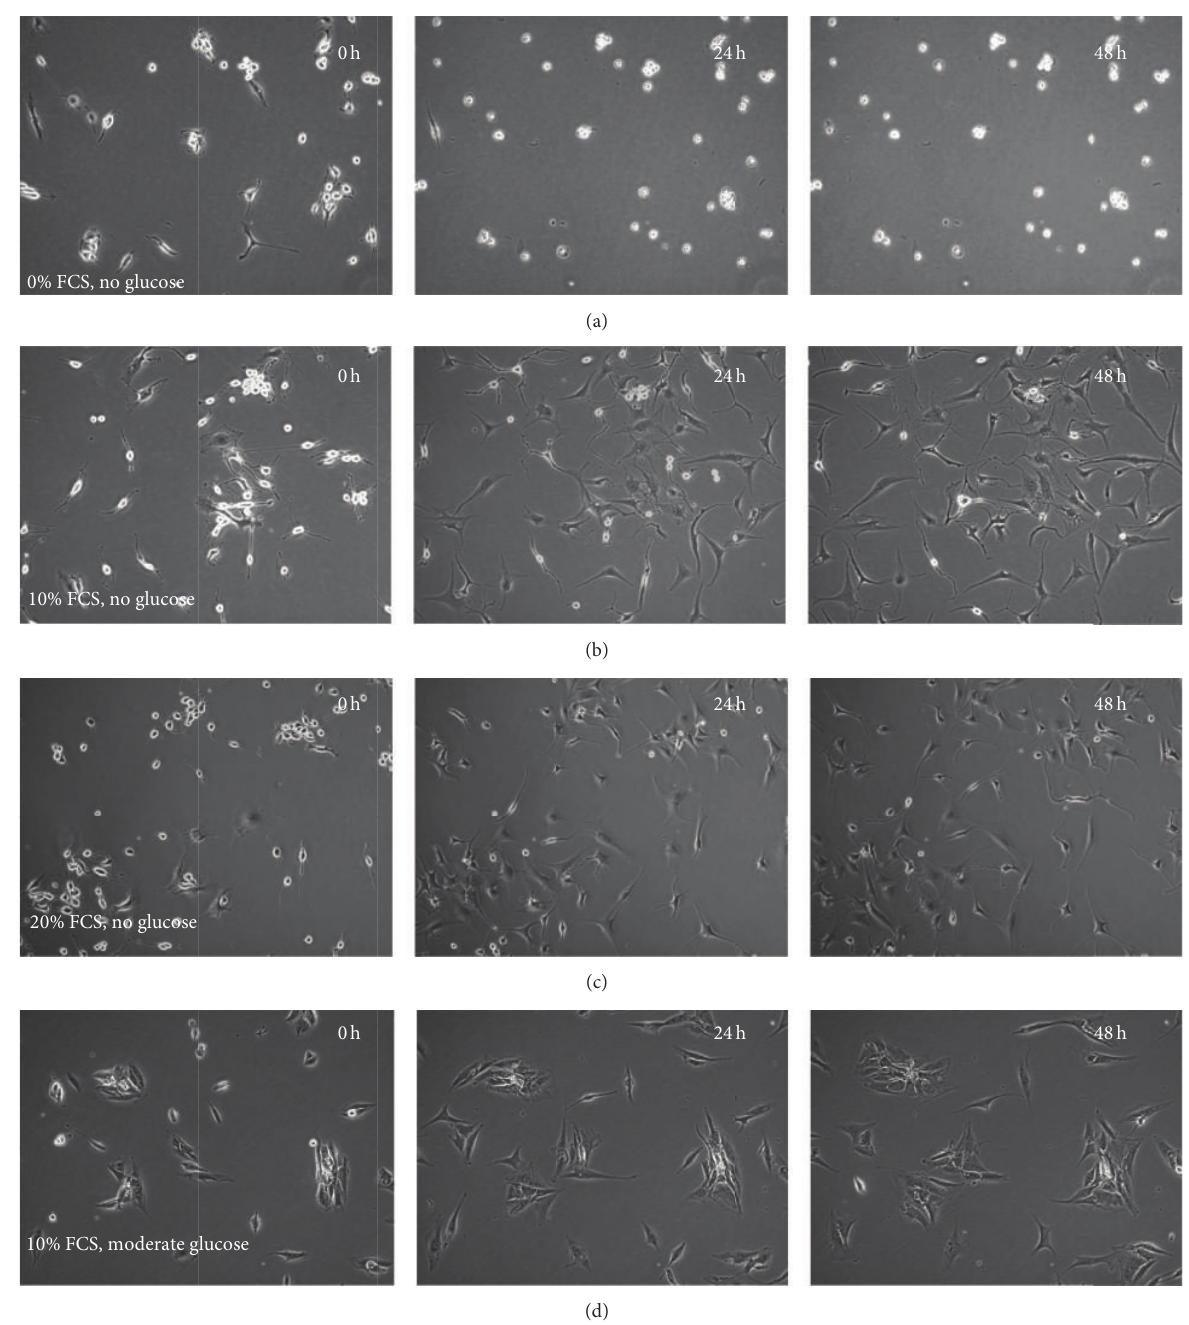
Figure 4: Changes in human NP cellular morphology with time. (a) Cells treated with 0% FBS and no glucose appeared “phase-bright” and semiadhered. This morphology showed no change over time, whereas cells treated with 10% FBS and no glucose (b) and 20% FBS with no glucose (c) showed recovery from a rounded phase-bright morphology to flattened live fibroblast morphology during the 48 hours; (d) cells treated with 10% FBS and moderate glucose were flattened and fibroblast-like and showed no discernible changes in morphology over time.